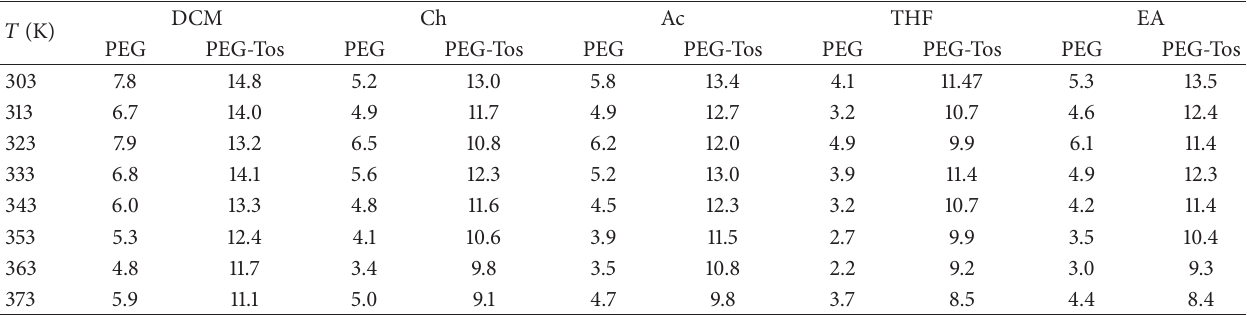
Table 2: The variation of free energy of specific interactions, −Δ𝐺 𝑆 𝐴 (kJmol −1 ), between PEG and PEG-Tos and polar probes for studied temperatures.